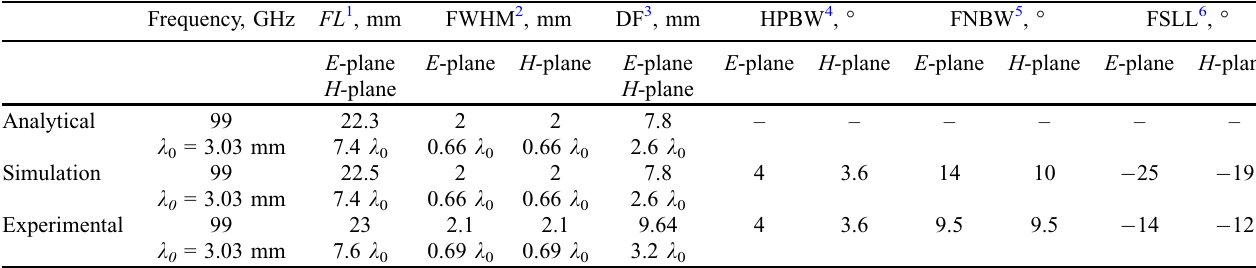
Table 1. Focal properties and radiation pattern